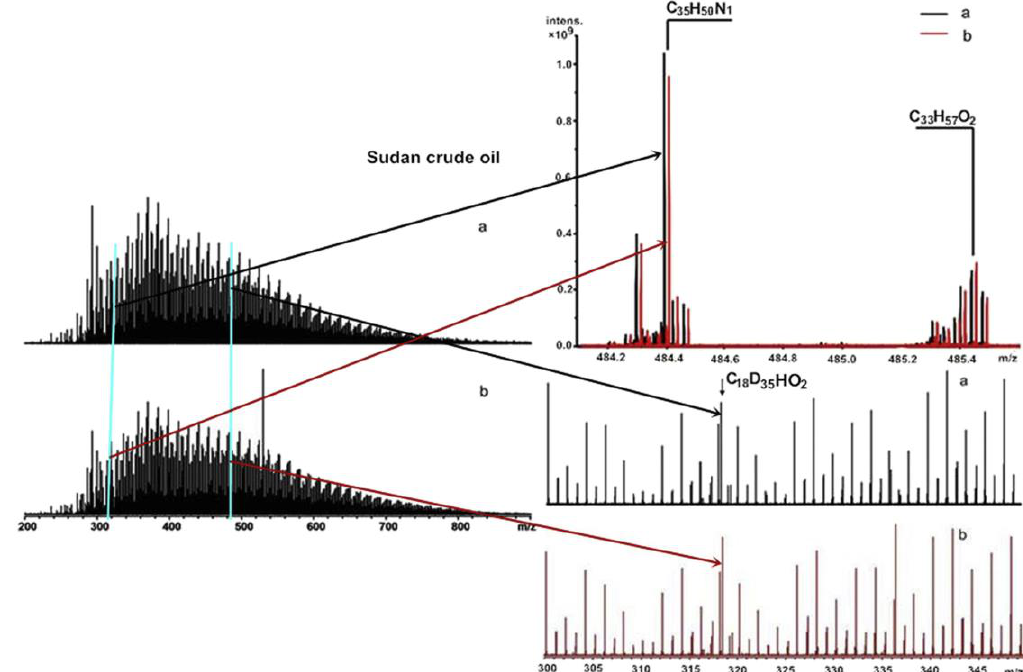
Figure 2. Negative ion Electrospray Ionization Fourier transform ion cyclotron (ESI FT-ICR) mass spectra of Sudan crude oil before and after microwave irradiation ( left ) and the segment enlarge mass spectra ( right ) (a: Crude oil; b: Crude oil after microwave). Reproduced with permission from [63], Copyright Elsevier, 2018.